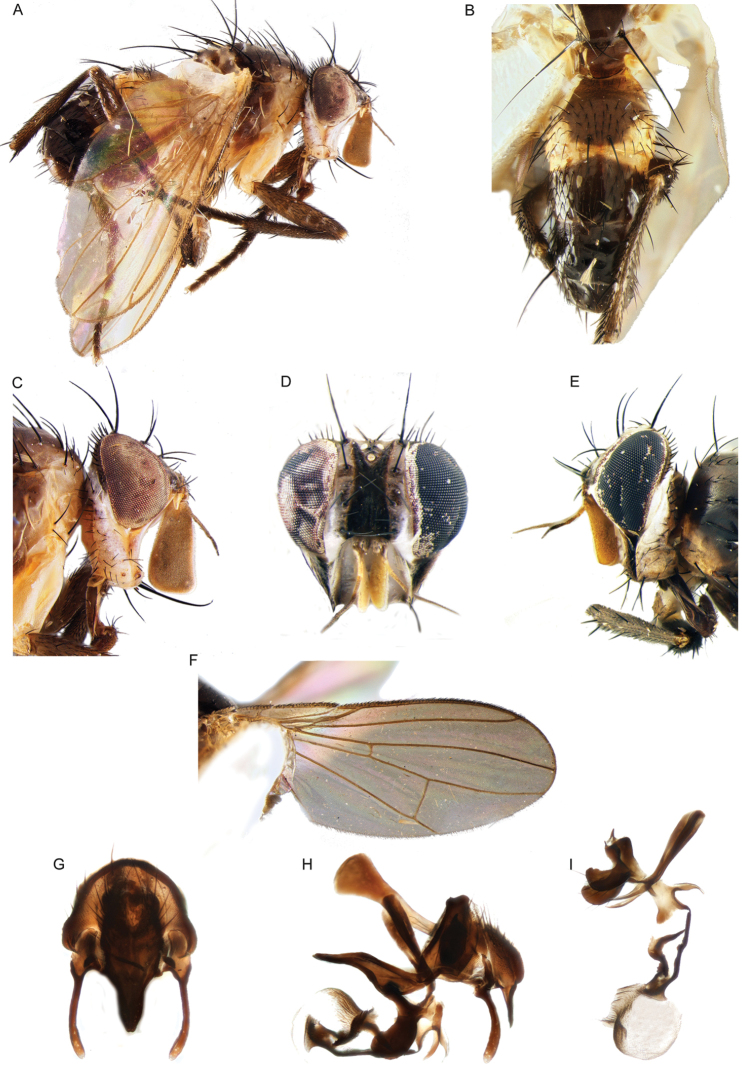
Kinabalumyia gen. nov. A–C, F–IKinabalumyia
pinax sp. nov. (Malaysia, Sabah) D–EKinabalumyia sp. ♀ (Philippines) AK.
pinax sp. nov., habitus in lateral view BK.
pinax sp. nov., abdomen in dorsal view CK.
pinax sp. nov., head in lateral view DKinabalumyia sp. ♀, head in frontal view, ♀ EKinabalumyia sp. ♀, head in lateral view FK.
pinax sp. nov., wing G–IK.
pinax sp. nov.: epandrial complex in posterior (G) and lateral (H) view I hypandrial complex in lateral view [A–C holotype; F–I paratypes].